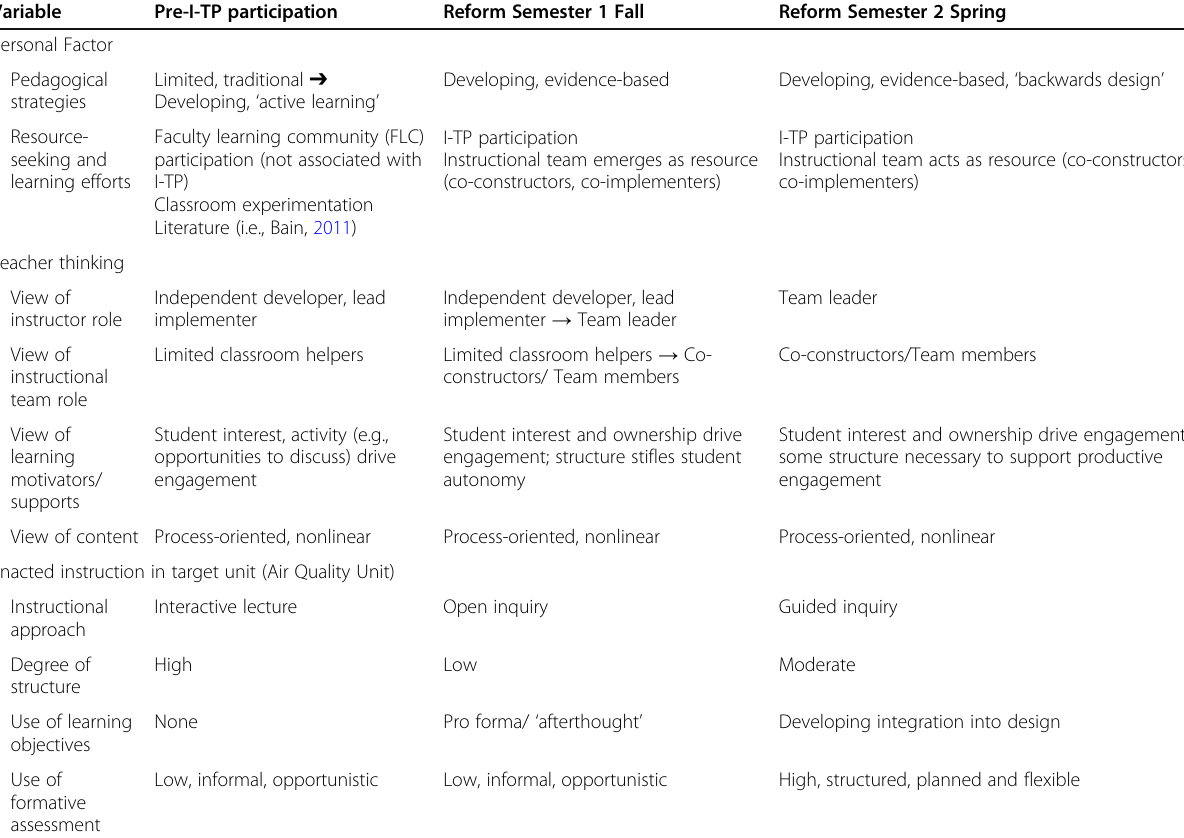
Table 3 Alignment of key personal factors, elements of teacher thinking, and enacted instruction in the Air Quality Unit